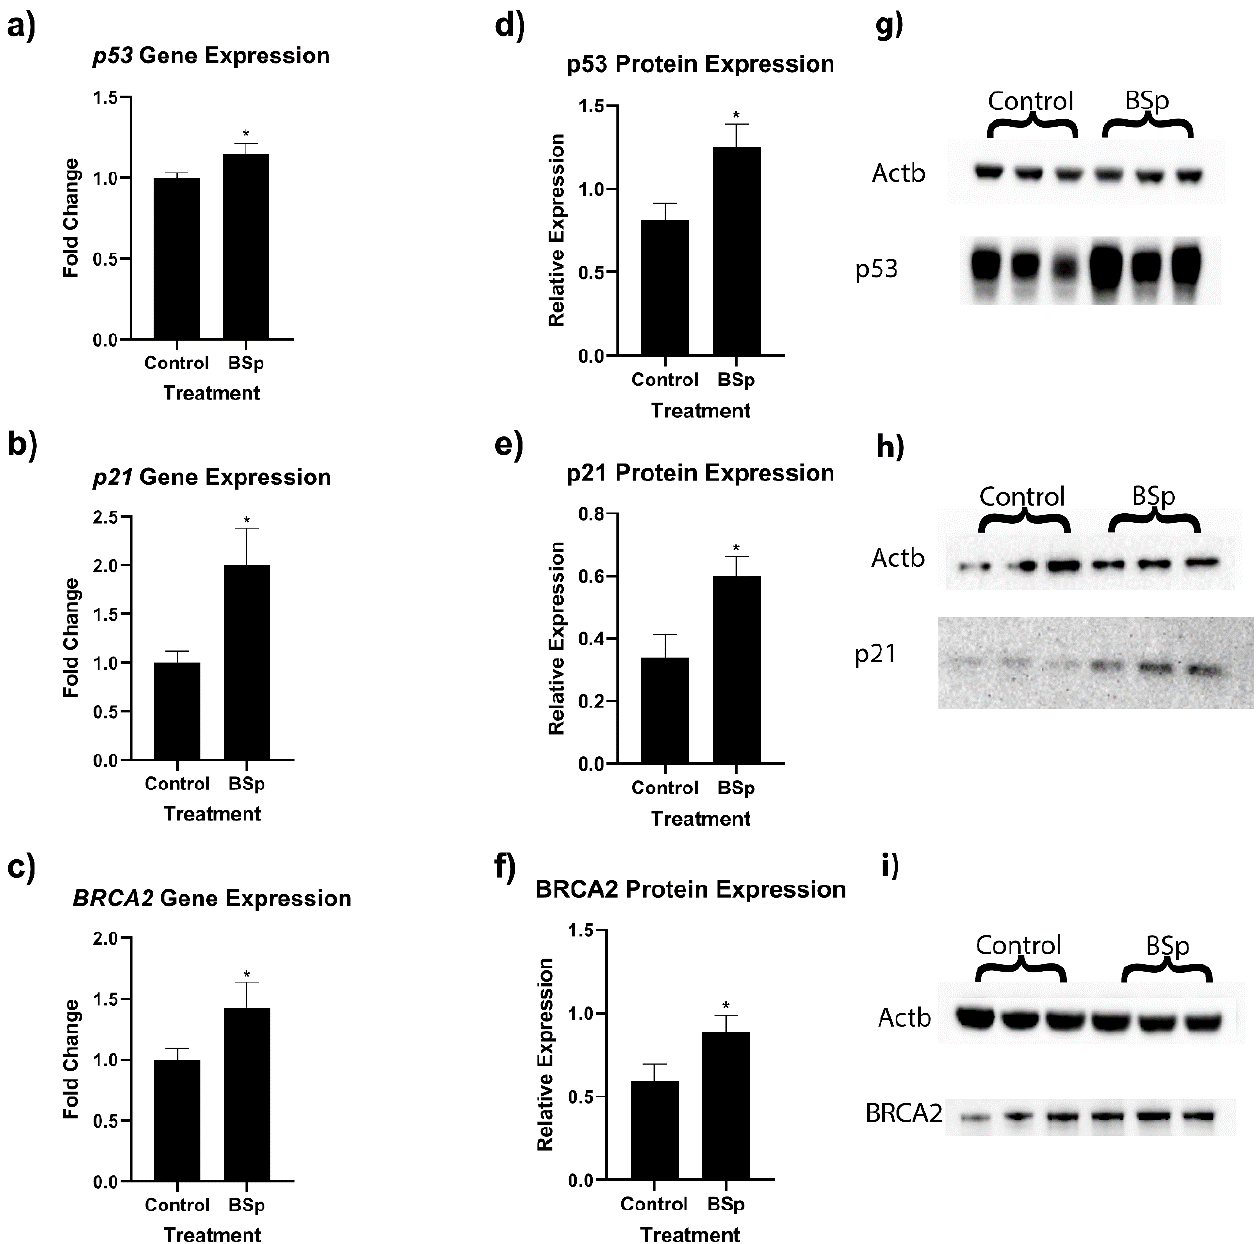
Figure 4. Expression of key tumor suppressor genes in HER2/neu mouse breast tumors. We observed significant increases in relative gene expression in p53 ( a ), p21 ( b ), and BRCA2 ( c ). We also observed significant increases in protein expression for p53 ( d , g ), p21 ( e , h ), and BRCA2 ( f , i ). For RT-qPCR, n = 10, and for Western blots, n = 6. * = p < 0.05. The uncropped blots are shown in File S1.